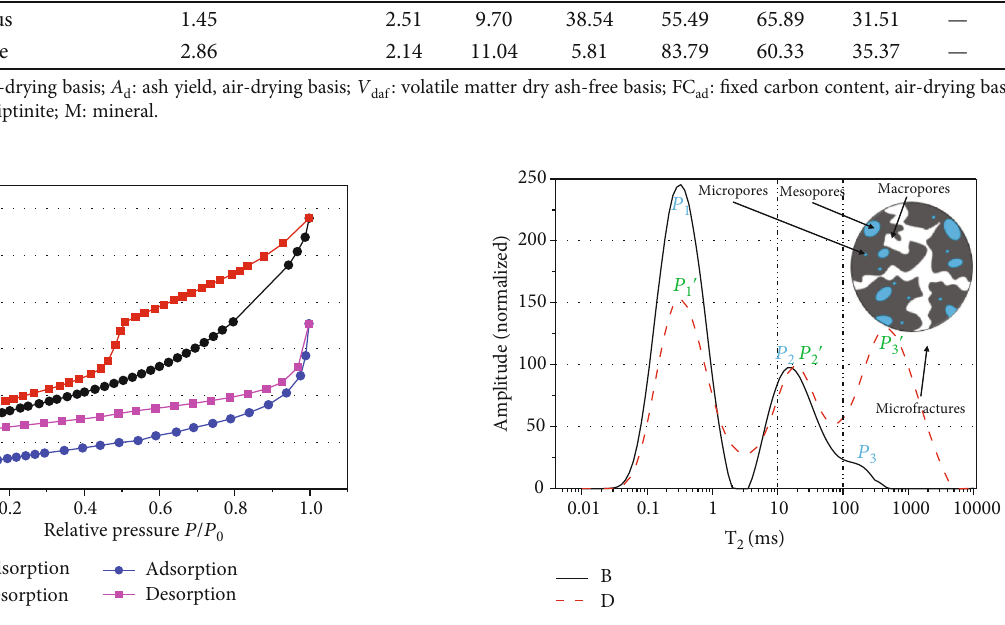
Figure 2: Nitrogen adsorption/desorption curves. Table 2: Results of low-temperature nitrogen adsorption experiments.